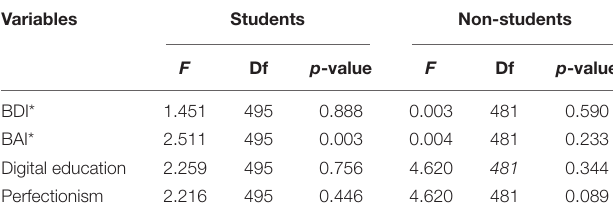
TABLE 3 | Location effects on mental health, digital education, and